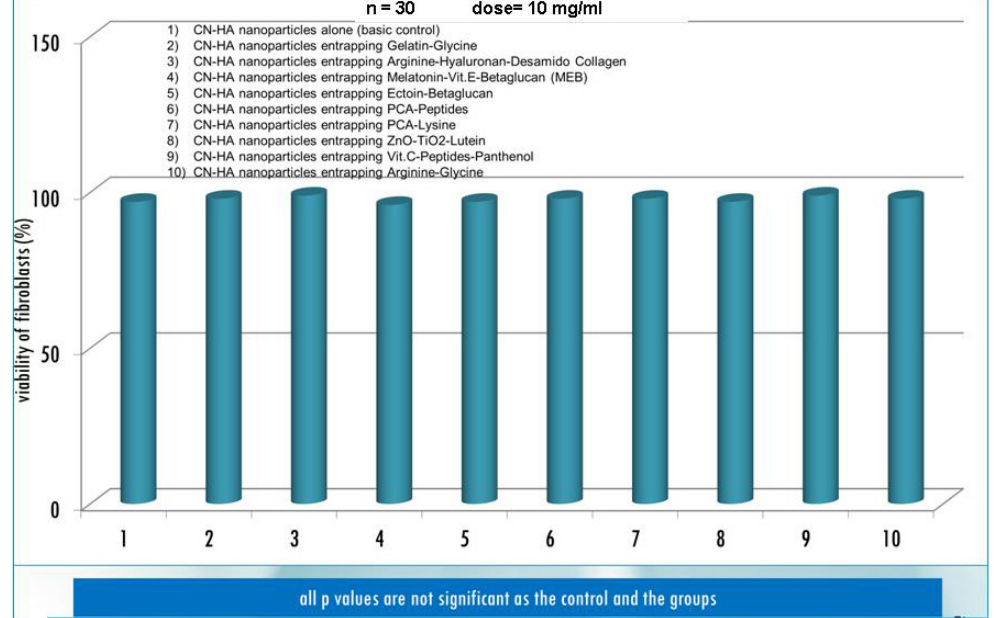
Figure 4. Effect of Chitin Nanofibril-Hyaluronan nanoparticles on the viability of fibroblasts. All p values are not significant as the control and the